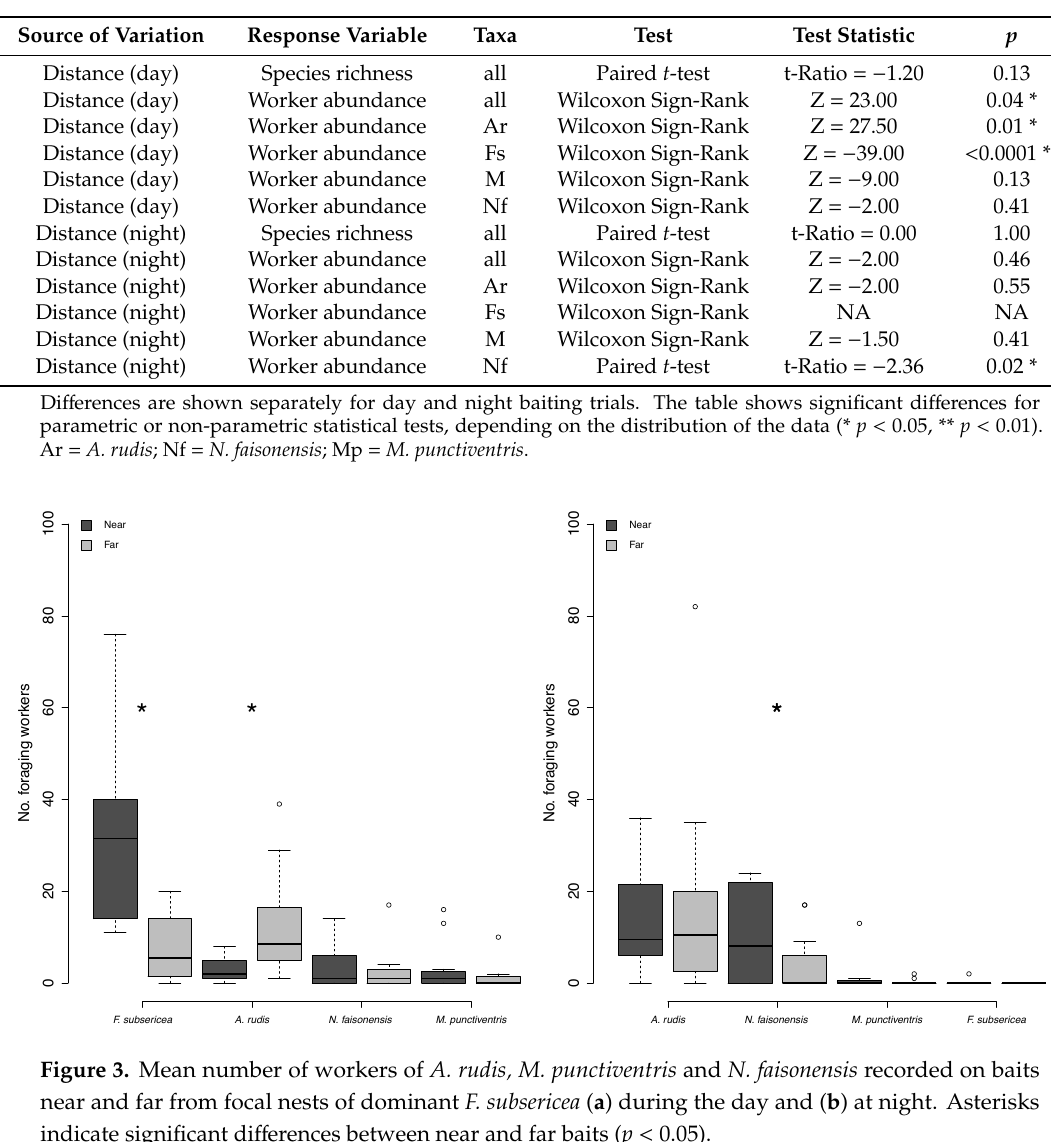
N. faisonensis workers on baits near than far from F. subsericea nests at night (Table 4, Figure 3b). 3.5. Are Temporal Patterns of Foraging Activity in Non-dominant Species Negatively Related to Those of the Dominant